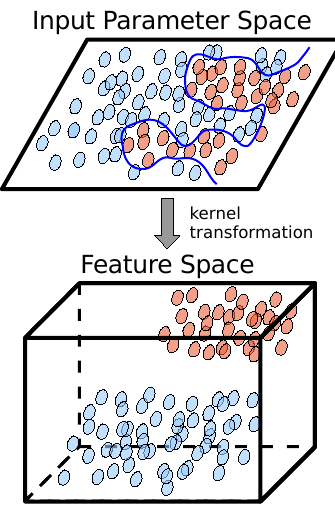
Fig. 4. Conceptual image showing the separability of the red and blue classes through kernel transformations in SVMs.